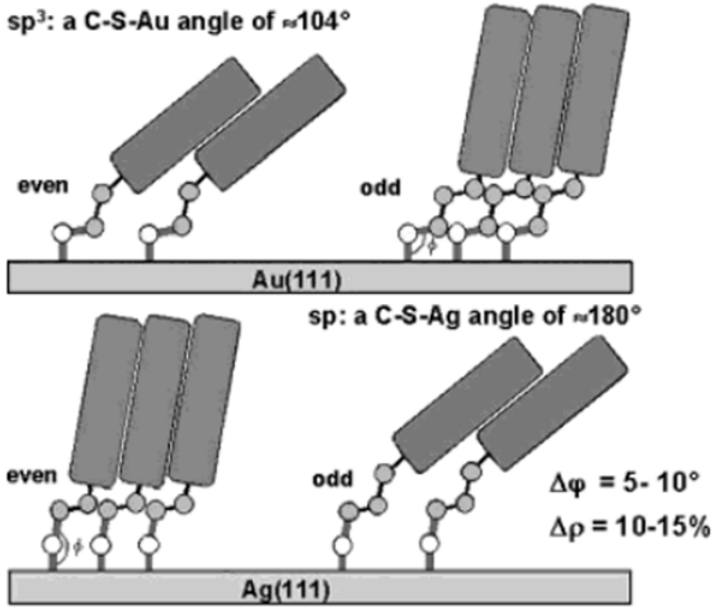
Figure 5. Schematic illustration of the orientation and packing structure of the TP n SAMs on Au and Ag, Graph is reprinted with permission from [46], Copyright 2004 American Chemical